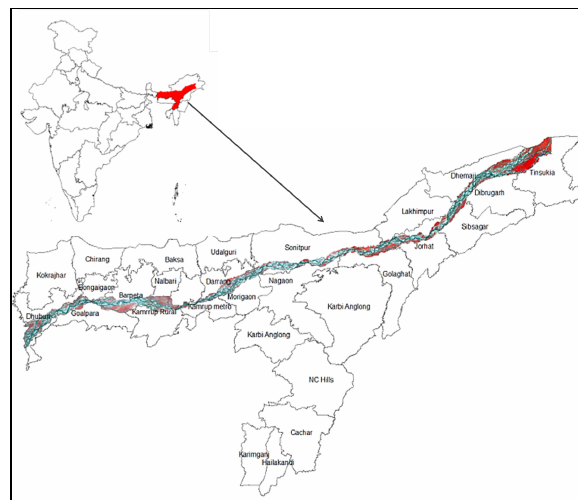
Figure 1. Brahmaputra River in Assam, India